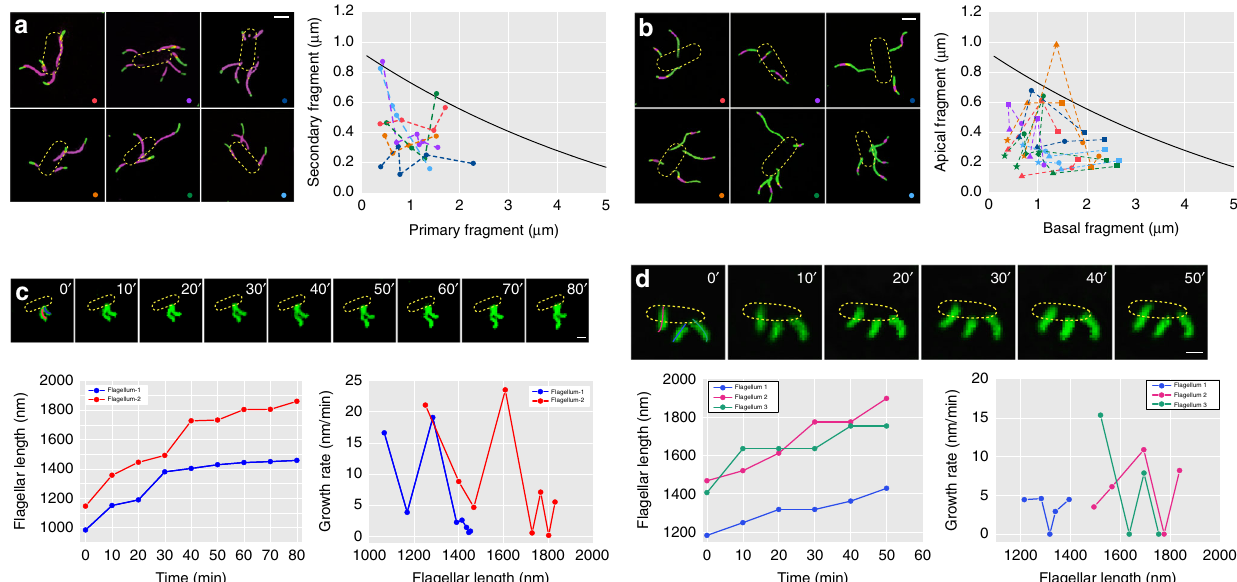
Fig. 4 Growth measurements of multiple fl agella on the single cell. a Double-color and b triple-color labeling were used to record fl agellar growth of several E. coli cells. For the double-color labeling in a , the relationship between secondary (green) and primary fragments (purple) are plotted, and the data points from the same cell are connected. For the triple-color labeling shown in b , the secondary (purple) versus primary fragment (green) lengths and the tertiary (green) versus secondary plus primary fragment (purple and green) lengths were analyzed. The data points corresponding to each individual fl agellum are indicated with the same symbol and fl agella from each individual cell are in the same color. The exponential fi t to the mean growth value vs. fl agellar length relationship from Fig. 2c is overlaid in black. Scale bars = 1 μ m. c , d Real-time fl uorescence tracking was performed to observe different fl agella growing on a single cell. Plots of fl agellar length versus time and the growth rates versus fl agellar lengths are